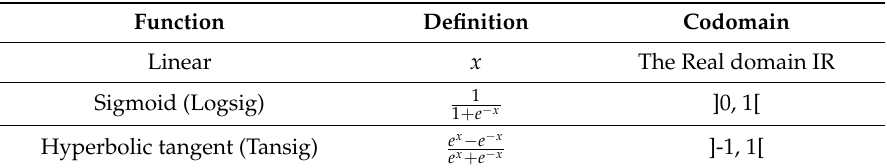
Figure 2. Details of a neuron ( up ) and MLP network ( down ). Table 1. Examples of activation functions.